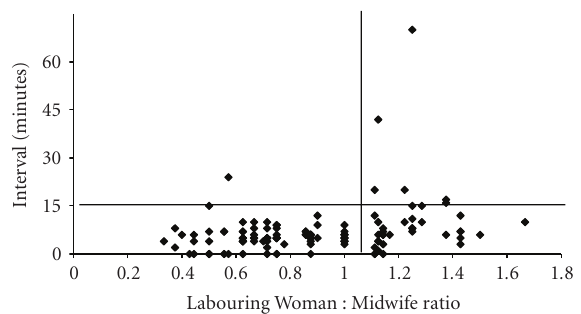
Figure 7: Transfer time to theatre versus Labouring Woman: Midwife ratio (grade 1).